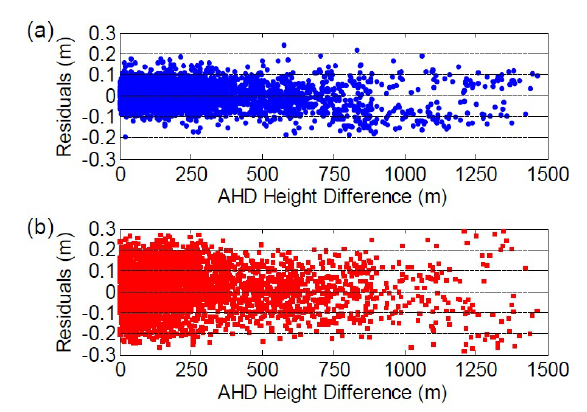
Figure 5: Mid Hunter residuals between (a) AUSGeoid09- and (b) AUSGeoid98-derived and oflcial AHD height differences over 3,320 possible vectors as a function of AHD height